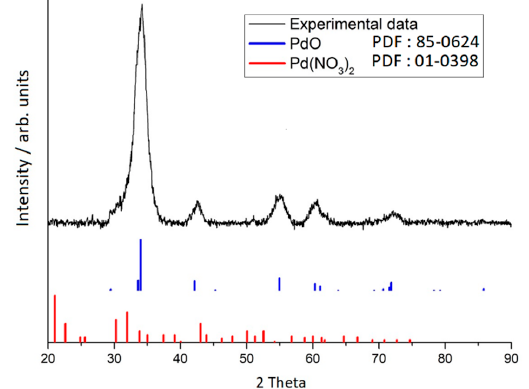
Figure 3. X-ray diffraction (XRD) of the centrifuged colloidal suspension, after drying on a silicon substrate. Reference diffraction patterns of palladium(II) oxide (PdO) (blue segments) and palladium(II) nitrate (Pd(NO 3 ) 2 ) (red segments) correspond to the Power Diffraction Files (PDF)s of palladium oxide and palladium nitrate, respectively.